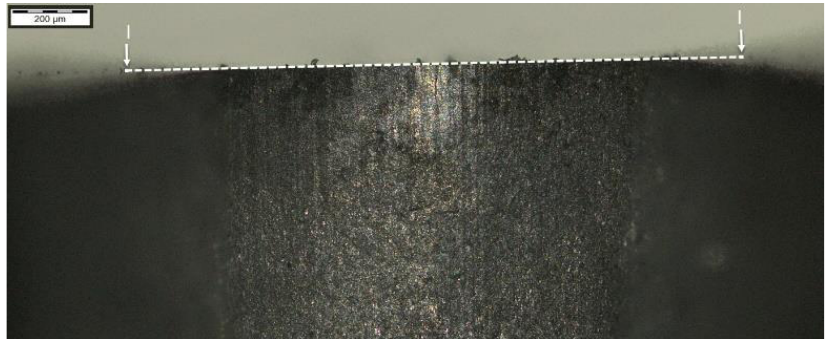
Figure 24. Localization of cross-section I-I, zone: 4A Ds.